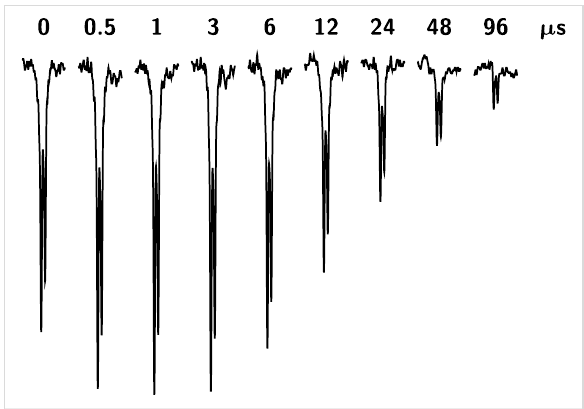
Figure 3: Time-resolved CIDNP signals of the 18 equivalent β protons (d, 0.98 ppm) of triisopropylamine (TIPA) in the photoreaction with xanthone (XA) as functions of the delay (given at the respective trace) between the laser flash and the sampling NMR pulse. Note the expo- nential increase of the delay with the spectrum number. Excitation intensity, ca. 80 mJ per flash; NMR pulse width, 1 . 0 µs; temperature, 279 K; amine concentration, 5 . 0 × 10 − 4 M; sensitizer concentration, 1 × 10 − 3 M. Further explanation, see